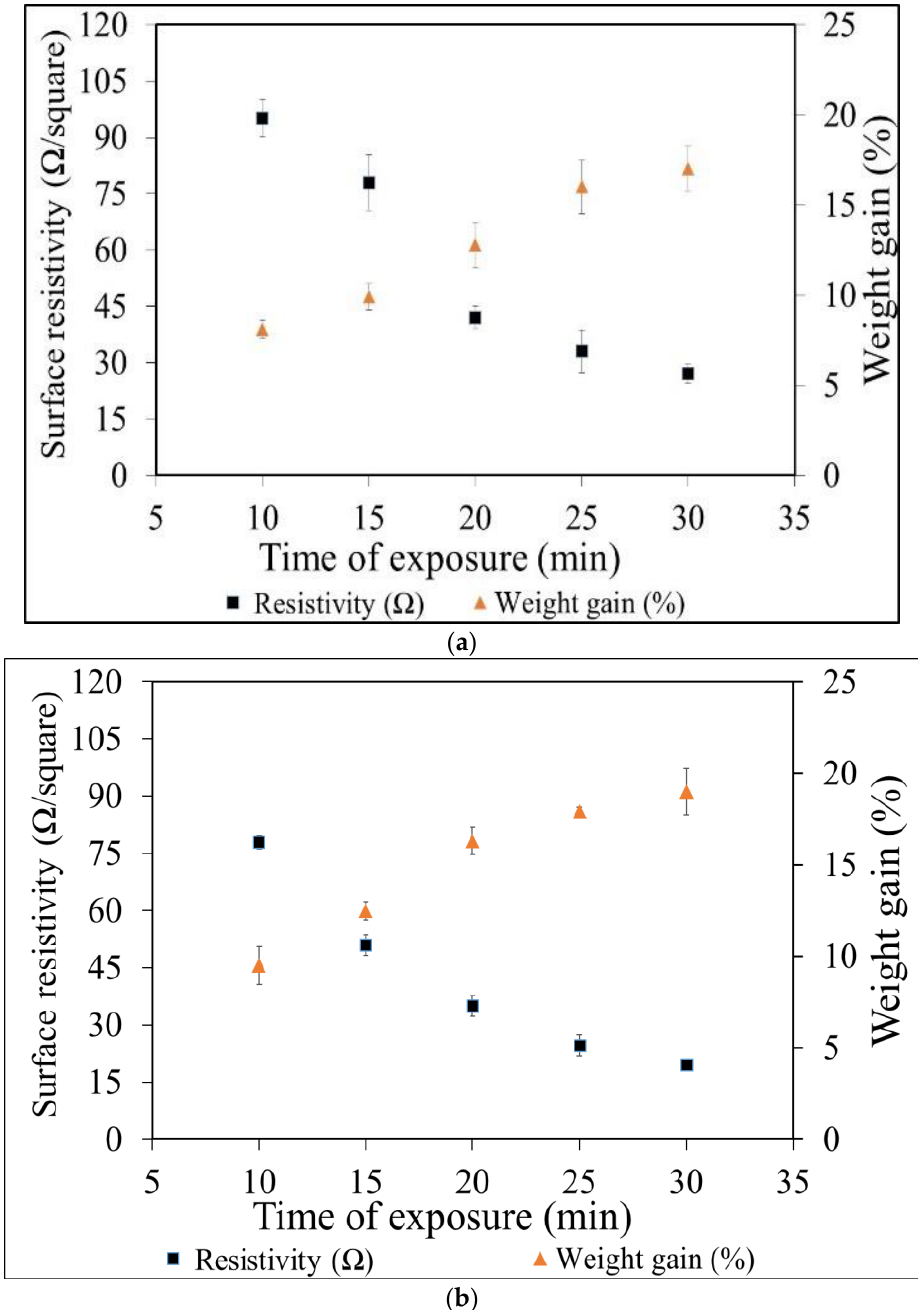
Figure 9 . Mass gain percentage with time of copper plating over ( a ) Cu-NPs coated woven cotton fabric, ( b ) Ag-NPs coated woven cotton fabric (bars are limits of 95% confidence interval) .